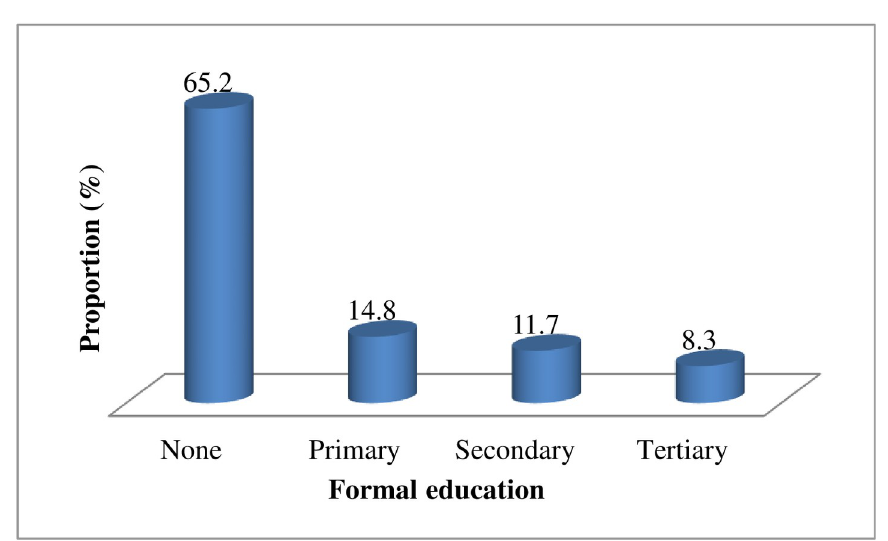
Fig 1. Formal educational status of Fulani pastoralists in North-central